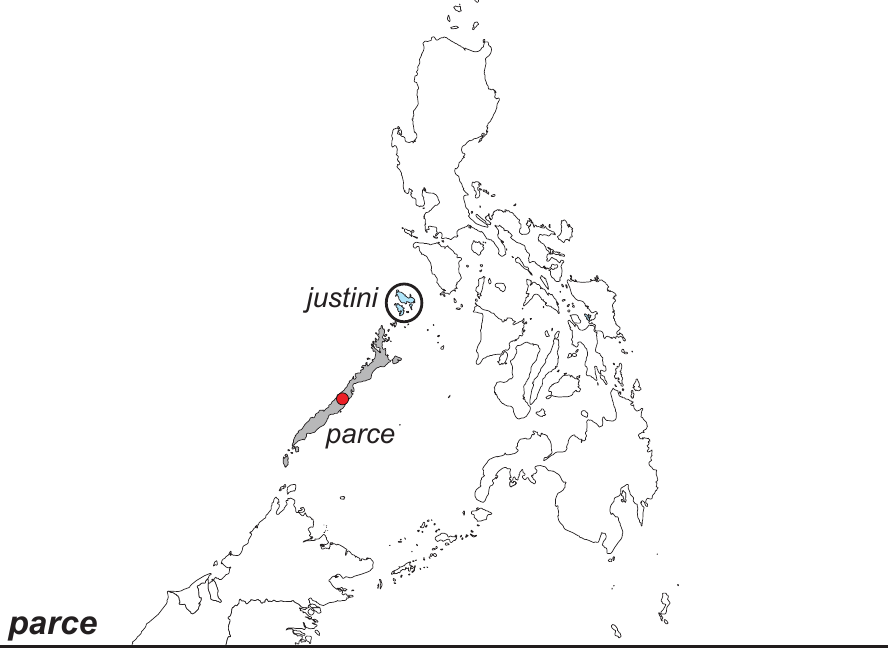
Figure 46. Distribution map of Elymnias parce